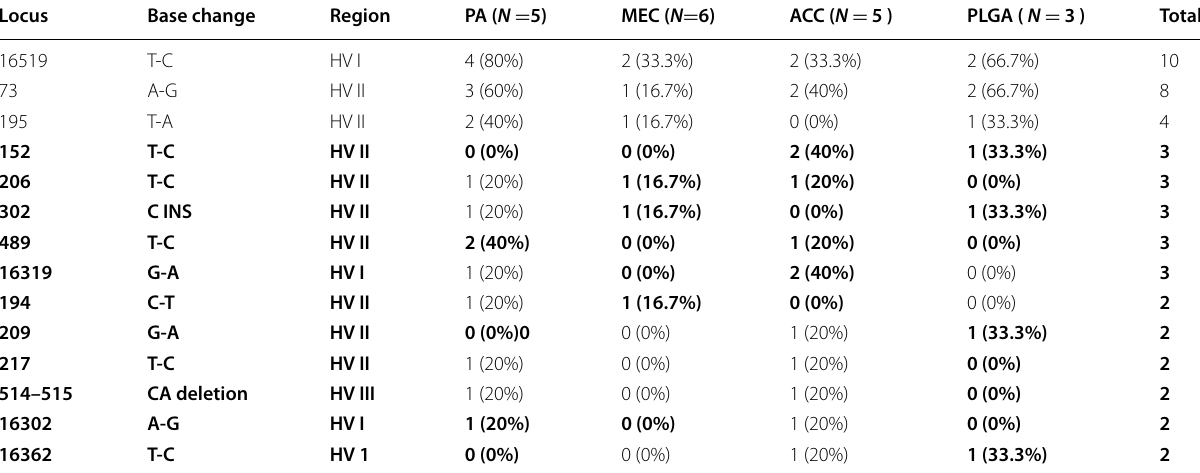
Table 1 Common D-loop variations among the groups